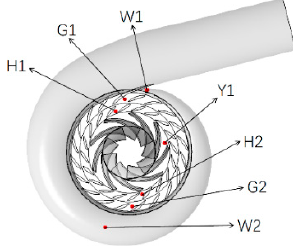
Figure 4. Schematic diagram of monitoring point arrangement.